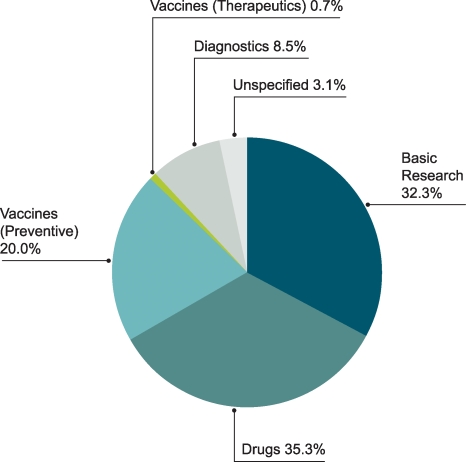
TB R&D Funding in 2007